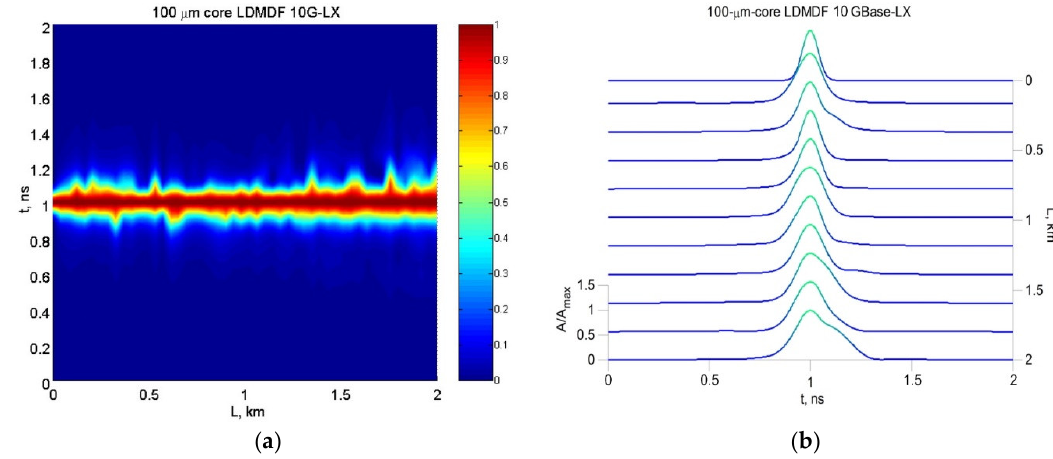
Figure 11. 10GBase-LX optical pulse dynamics during propagation over a 100 μm core LDMDF with a total length of 2 km without special launching conditions: ( a ) pulse dynamics; ( b ) diagram of pulse propagation.